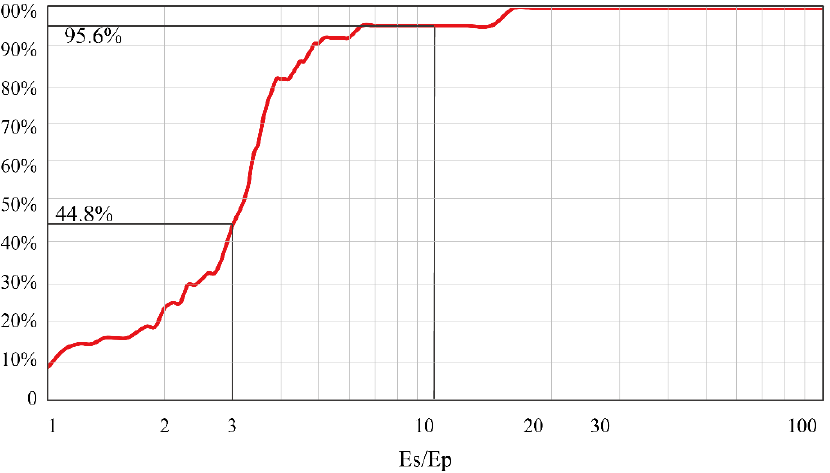
Figure 16. Distribution of the ES/EP value of MS events controlled by excavation unloading inten-